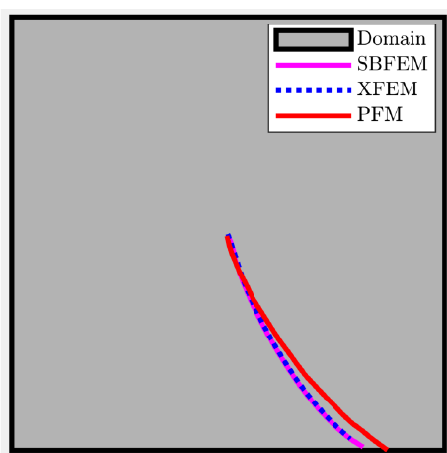
Figure 19. Shear test crack-paths obtained from SBFEM, XFEM and PFM-based crack propagation analysis.